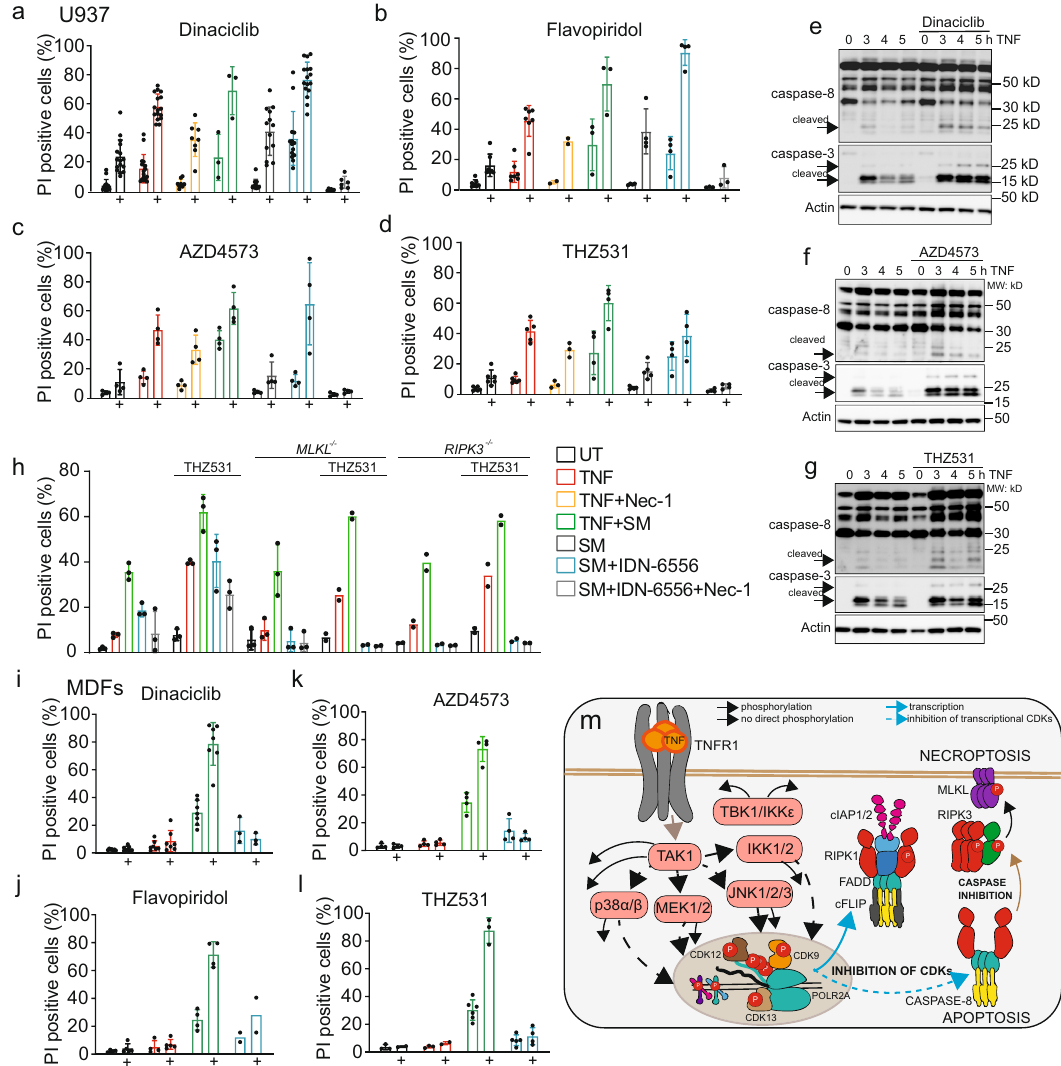
Fig. 6 CDK9 and CDK12/13 inhibit TNF-induced cell death. a – d Cell-death analysis by fl ow cytometry of propidium iodide-stained U937 cells. Cells were pretreated for one h with CDK inhibitors Dinaciclib (6 nM) ( a ), Flavopiridol (60 nM) ( b ), AZD4573 (6 nM), and ( c ) THZ531 (200 nM) ( d ) or left untreated (black) before treatment with TNF (red), TNF and necrostatin-1 (50 μ M, yellow), TNF and SM (Birinapant, 1.25 μ M, green), SM alone (gray), SM and IDN- 6556 (10 μ M, blue), or SM, IDN6556, and necrostatin-1 (light gray) for 24 h (±SD, n = 3 biologically independent experiments). e – g Immunoblots of U937 cells stimulated with TNF or TNF in combination with CDK inhibitors stained for caspase-3 and -8 and β -actin ( n = 2 biologically independent experiments). h Cell-death analysis by fl ow cytometry of propidium iodide-stained wt and MLKL- and RIPK3-de fi cient U937 cells stimulated as described for 24 h (±SD, n = 2 biologically independent experiments). i – l Flow cytometry analysis of propidium iodide-stained wild-type MDFs treated as indicated (SM, compound A (2 μ M); pan-CDK inhibitor, Dinaciclib (12 nM); CDK9 inhibitors, Flavopiridol (60 nM), AZD4573 (6 nM); CDK12/13 inhibitors THZ531 (800 nM)) (±SD, n = 2 biologically independent samples and experiments). m TNF-signaling scheme highlighting the role of the kinases and speci fi cally CDKs in cell death as inferred from our data. Source data are provided as source fi